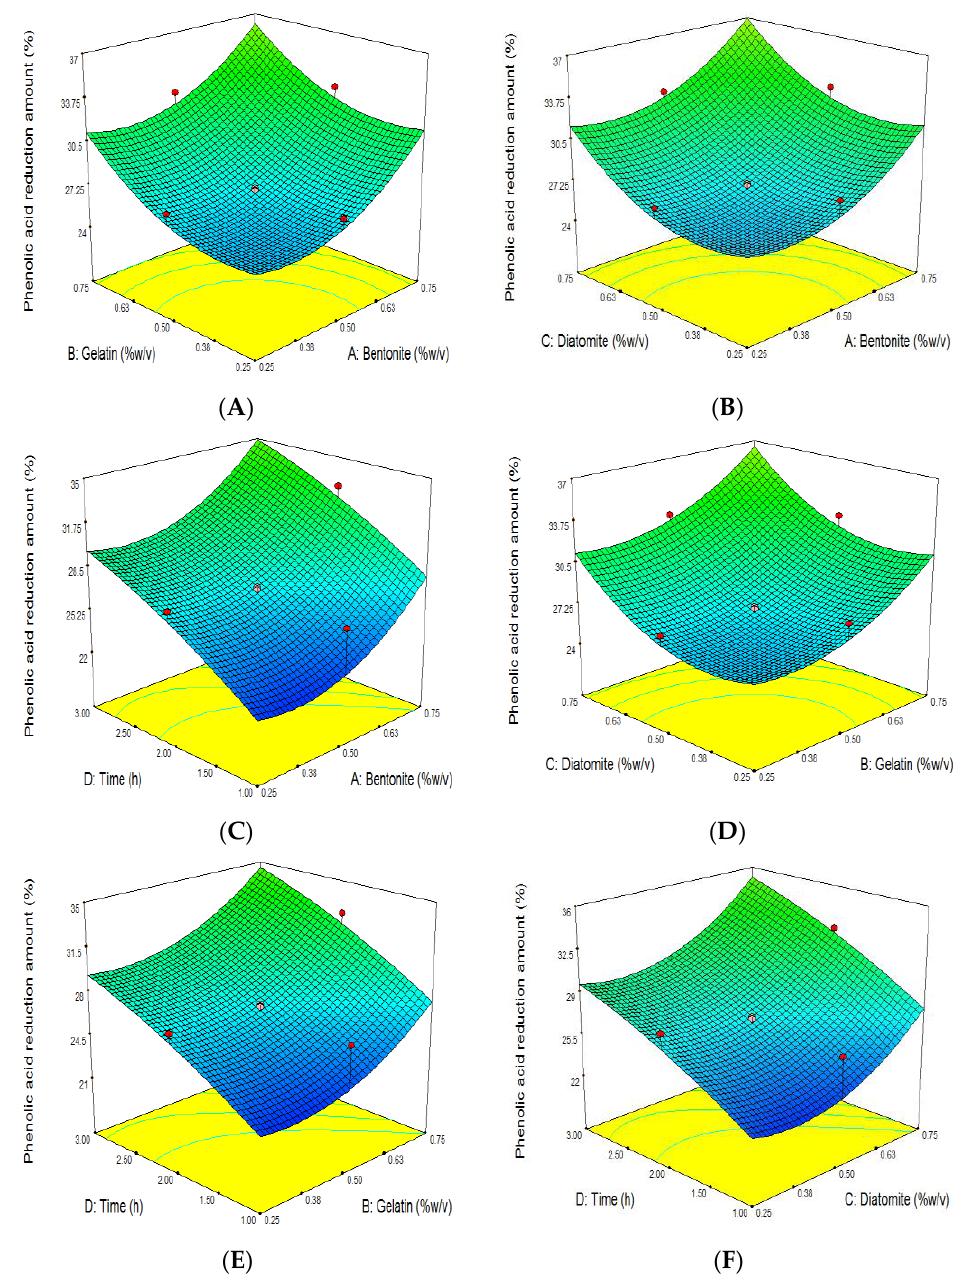
Figure 2. Response surface plot of the effects of bentonite, gelatin, and diatomite concentration and clarifying time on grape juice’s phenolic acid reduction amount (%). Influence of ( A ): gelatin and bentonite, ( B ): diatomite and bentonite, ( C ): time and bentonite, ( D ): diatomite and gelatin, ( E ): time and gelatin, ( F ): time and diatomite, on grape juice’s phenolic acid reduction amount (%).